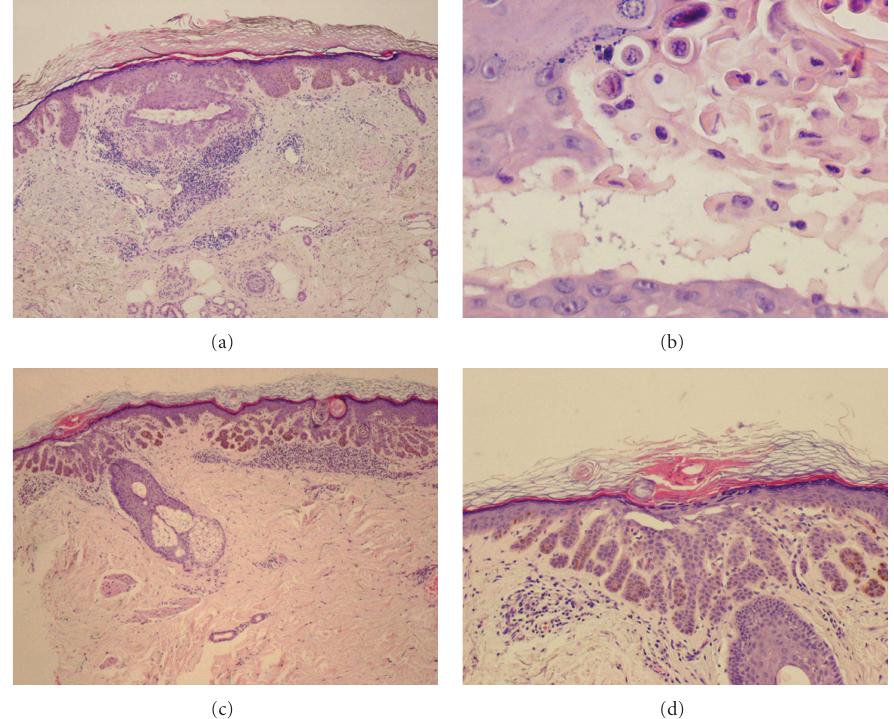
Figure 2: Hematoxylin and eosin. (a) Discrete hyperkeratosis, elongated rete ridges with digitiform projections, and focal acantholysis with formation of linear clefts. Presence of mixed dermal inflammatory infiltrate. (b) Dyskeratotic cells in the interior of a acantholytic cleft. (c) and (d) Digitiform elongation of the rete ridges, with hyperpigmentation of the basal layer confined to the tips of the rete ridges. Suprabasal